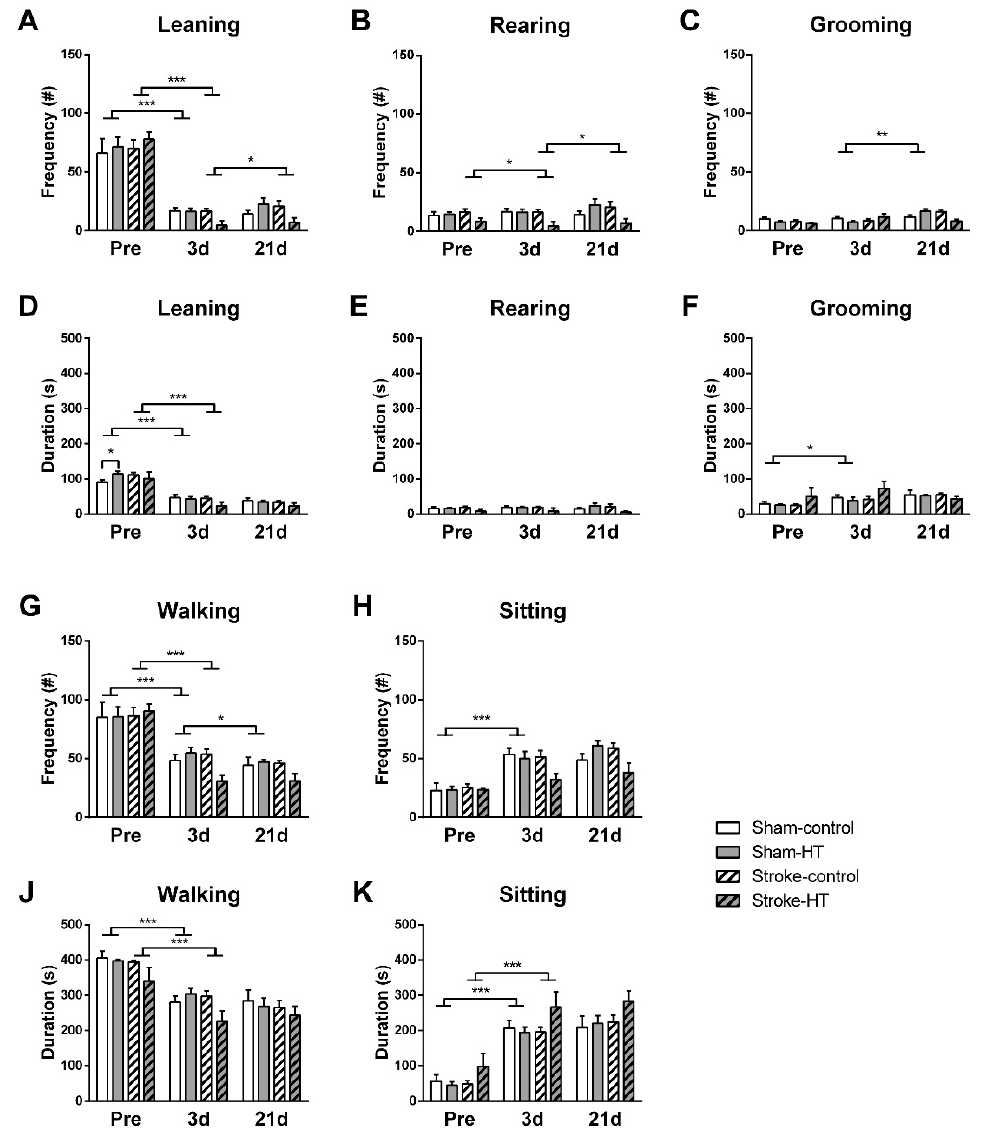
Figure 4. Behaviors in the open field. The behaviors of the mice in the arena during the open field were manually scored as another measure of locomotion, activity, and explorative behavior. ( A – C , G , H ) Frequency and ( D – F , J , K ) duration of leaning, rearing, grooming, sitting, and walking were quantified pre-surgery and three and 21 days after surgery. ( A , G ) All mice showed decreased frequency of wall leaning (Sham: p < 0.001; Stroke: p < 0.001) and walking (Sham: p < 0.001; Stroke: p < 0.001) and ( D , J ) also spent less time performing these behaviors (Wall leaning: Sham: p < 0.001; Stroke: p < 0.001; Walking: Sham: p < 0.001; Stroke: p < 0.001) at three days post-stroke, ( K , F ) while they spent more time sitting (Sham: p < 0.001) and grooming (Sham: p < 0.028). ( C ) At baseline and three days post-stroke, sham-HT mice groomed less frequently than sham-control mice ( p < 0.036; not shown in graph). ( B ) Stroke mice also reared less frequently at three days compared to pre-stroke ( p < 0.012). ( G ) At 21 days post-stroke, walking frequency ( p < 0.026) was even further decreased in sham mice, ( A , B ) whereas stroke show increased rearing frequency ( p < 0.012) and wall leaning frequency ( p < 0.020). ( C ) Sham mice groomed more frequently at 21 days compared to three days post-stroke ( p < 0.004). Values represent mean ± SEM.* p < 0.05, ** p < 0.01, *** p < 0.001.